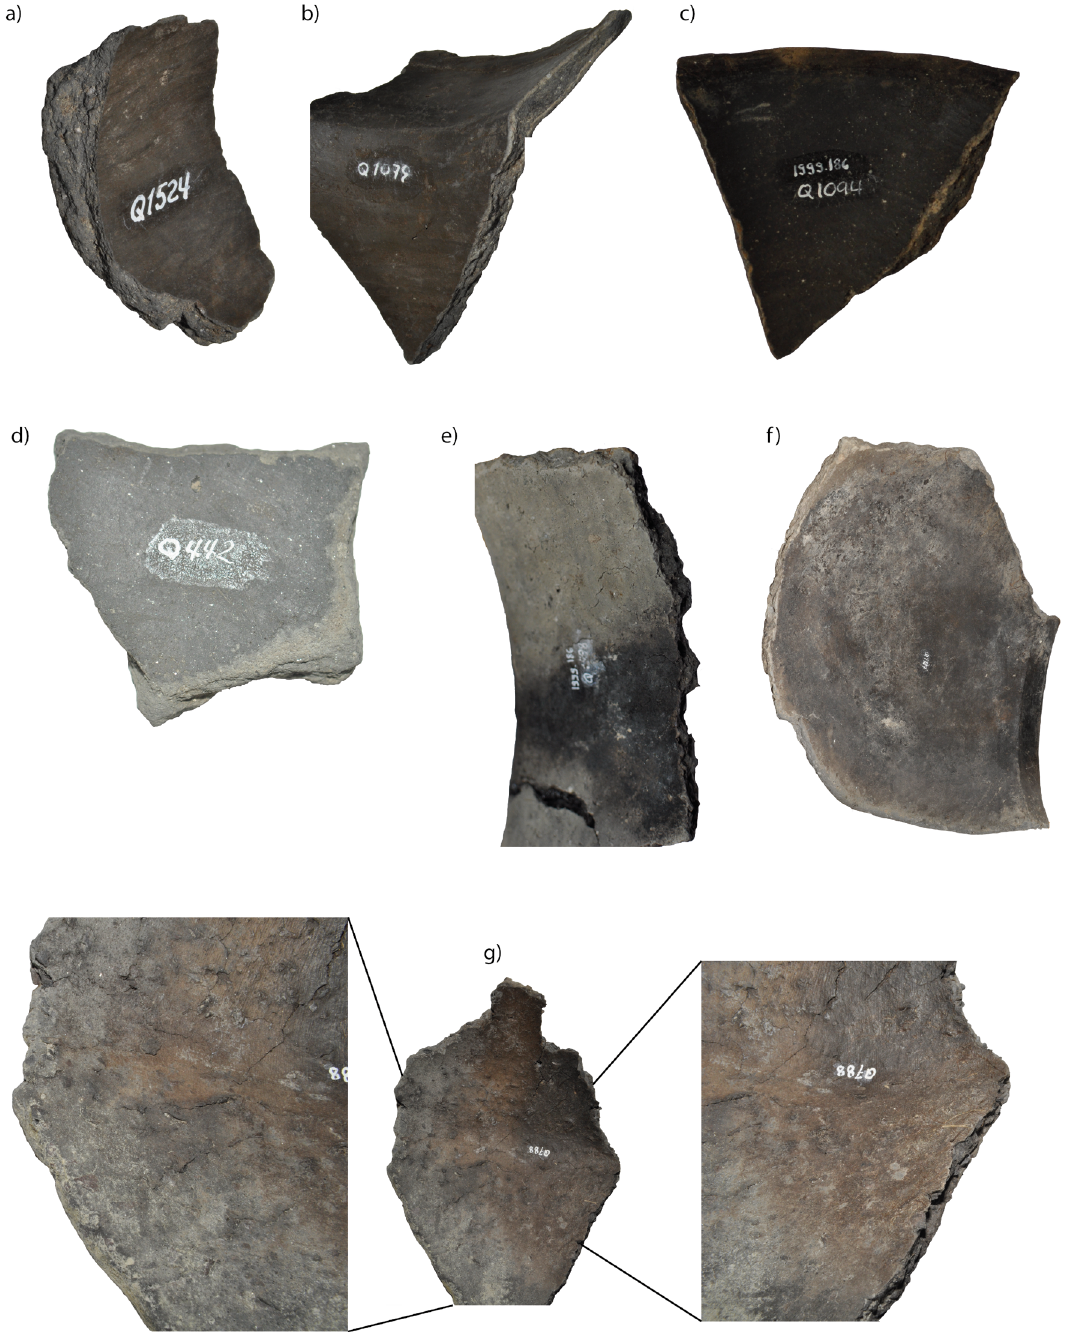
Figure 2. Differing states of erosion/abrasion on ceramic sherds from Zürich-Alpenquai. a, b, c: No or little erosion (Classes 1 and 2), d; Heavy erosion (Class 4); e: Mixed erosion – Classes 2 (right edge) and 3 (upper edge); f: Mixed erosion – Classes 2 (lower right edge), 3 (left edge) and 4 (lower edge); g: Mixed erosion – Classes 1 & 2 (right enlargement) and 3 & 4 (left enlar- gement) (Photographs by the author, with permission of Zürich Cantonal Archaeology